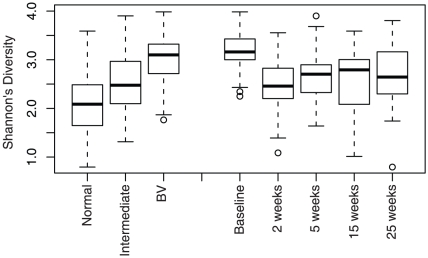
Diversity of the vaginal microbiota and the impact of antibiotics.The species diversity was measured by calculating Shannon's Diversity index [31]. The data was partitioned either by Nugent category [17], or by treatment time-point. Metronidazole treatment (week 0) reduced the diversity at two weeks but a slightly higher diversity was observed at later follow-up time-points indicating a return to a more diverse microbiota.